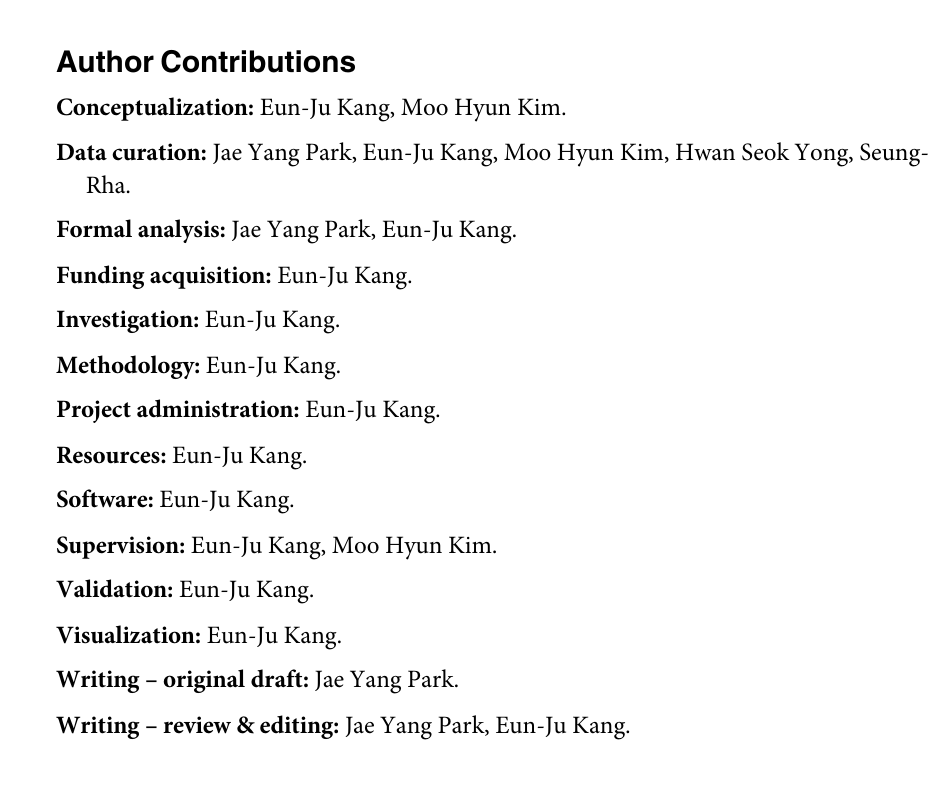
S1 Table. Per-vessel analysis of diagnostic performance of CCTA. S2 Table. Minimal data set for Tables 1–5 and S1 and Figs